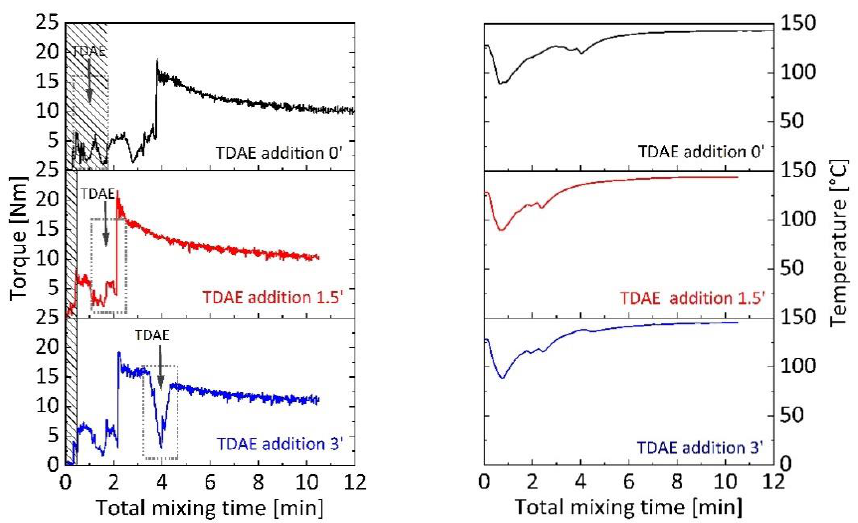
Figure 1. Mixing torque and temperature curves versus total mixing time for silica-filled styrene– butadiene rubber (SBR)/butadiene rubber (BR) binary blends with 5 phr Treated Distillate Aro- matic Extract (TDAE) content at different addition times.